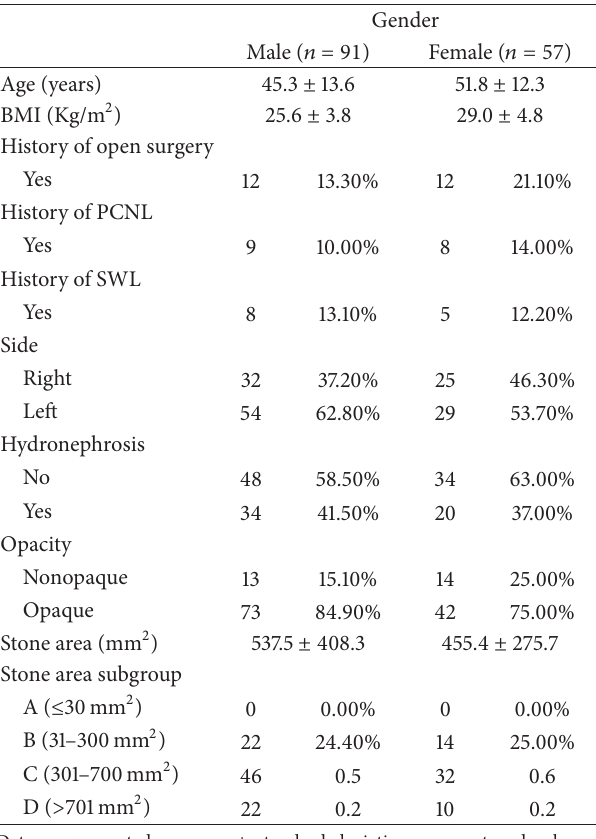
Table 1: Demographic data and specificities of the stone in men and